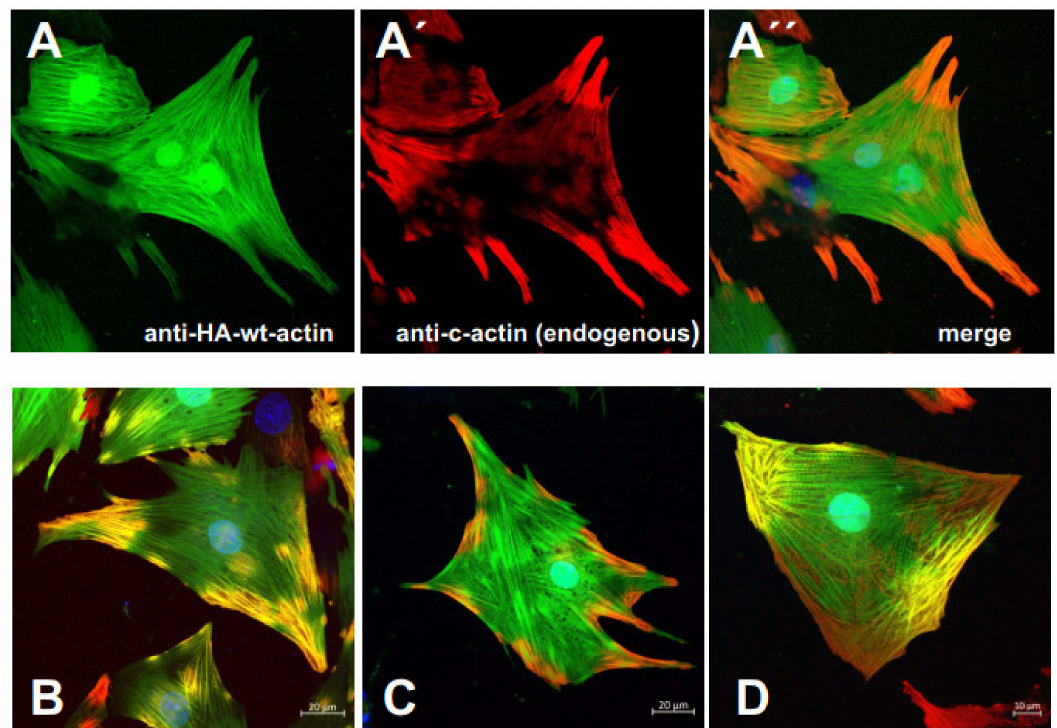
Figure 7. NRCs expressing HA-tagged c-actin variants counterstained with anti-c-actin mAB. ( A ) NRCs transduced with an adenoviral vector containing HA-tagged wt c-actin stained with anti-HA (green) and ( A’ ) with anti-c-actin mAB (red), ( A” ) merge. Note localization of endogenous c-actin in cell periphery and extensions. ( B ) Merged images of identical immunostaining of NRCs infected with HA-tagged p.A295S; ( C ) with p.R312H, and ( D ) with p.E361G. Note co-localization of endo- and exogenous c-actin in ( B , D ), whereas in ( C ) NRCs were infected with HA-tagged p.R312H the endogenous c-actin appears more peripherally concentrated. Bars: 20 µ